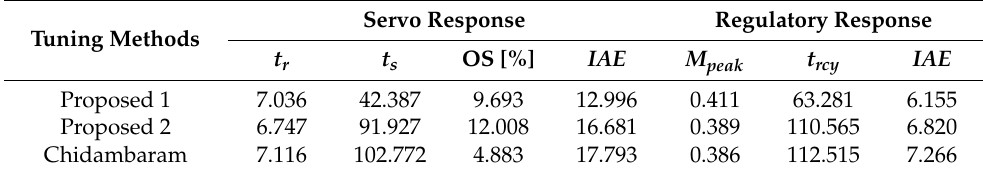
Table 9. Performance comparisons for 10% uncertainty process P 3 .